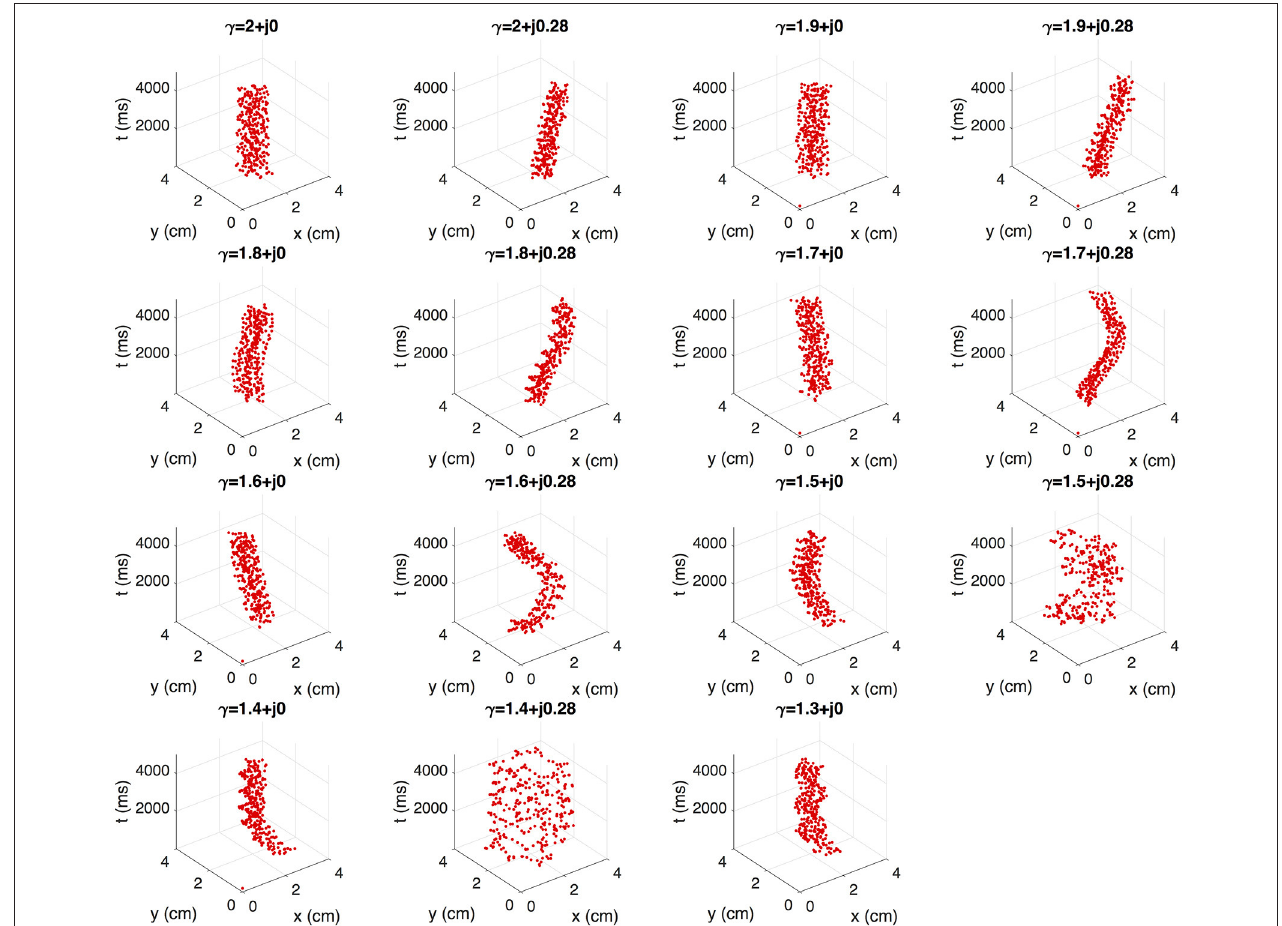
FIGURE 7 | Effect of γ on the rotor dynamics represented by singularity